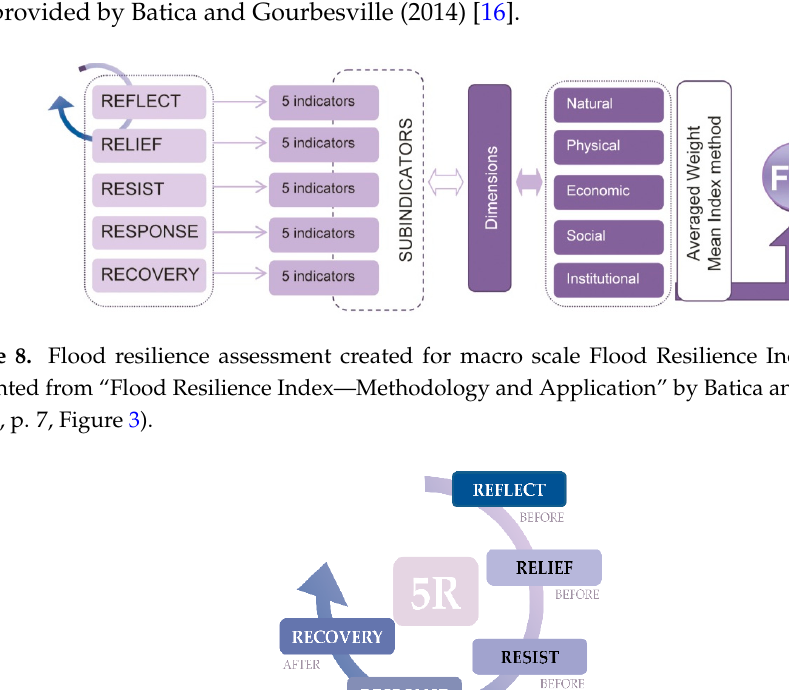
Figure 9. Defined elements for flood risk management cycle—CORFU project (reprinted from “Flood Resilience Index—Methodology and Application” by Batica and Gourbesville (2014), p. 3, Figure 1). As a result of an initial analysis within the CORFU project, a matrix comprising a number of indicators has been created. The value of each indicator ranges from 0 to 5, corresponding to the description provided in Table 1. Table 1. Scales for Flood Resilience Index.